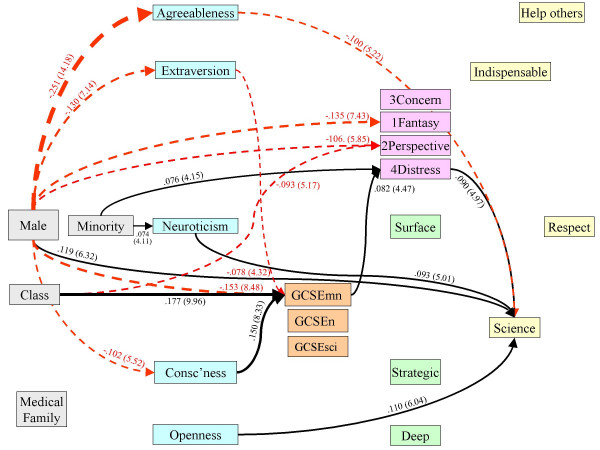
A reduced version of figure 1 in which the only paths shown are those with direct or indirect influences upon generic motivational factor (Science). All variable names have been left in the diagram, and are in the same positions as in figure 1.